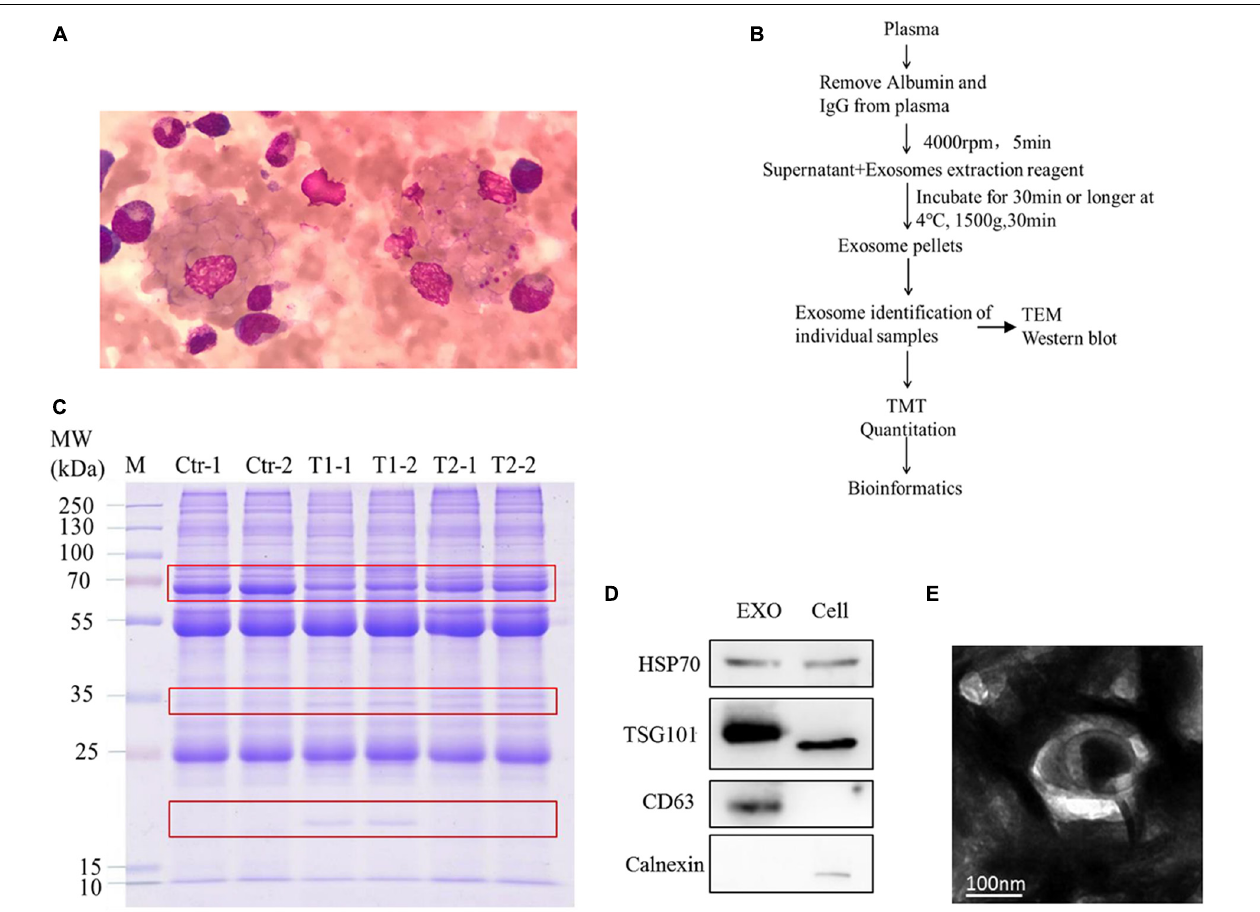
FIGURE 1 | Bone marrow samples and plasma exosomal samples obtained from patients. (A) Wright–Giemsa staining of a smear of bone marrow aspirate shows hemophagocytic macrophages, including one with numerous platelets and red cells. (B) Overview of methodological approaches in high-throughput mass spectrometry-based proteomic analyses of extracellular vesicles. (C) Similar protein amounts (measured with the BCA assay) of six plasma exosome samples run on 4–20% gradient SDS-PAGE gels. The protein profile in the gel was visualized by Coomassie brilliant blue staining. (D) Western blot analysis of the positive exosome markers HSP70, TSG101, and CD63 and the negative exosome marker calnexin. (E) Transmission electron microscopy appearance of exosomes (bar, 100